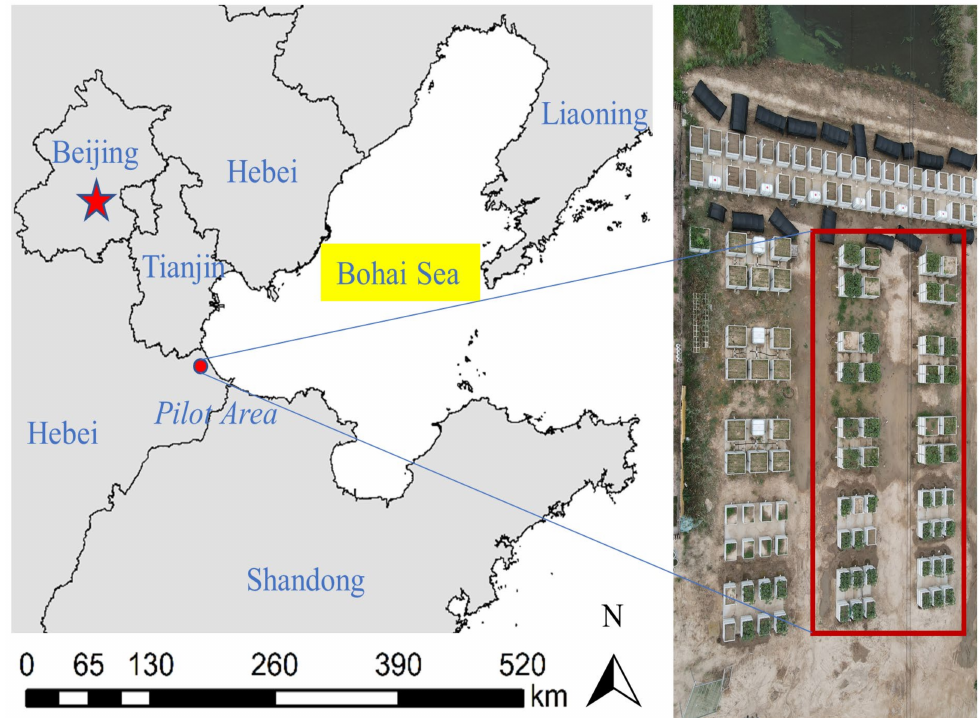
Figure 2. The pilot site and distribution of simulation